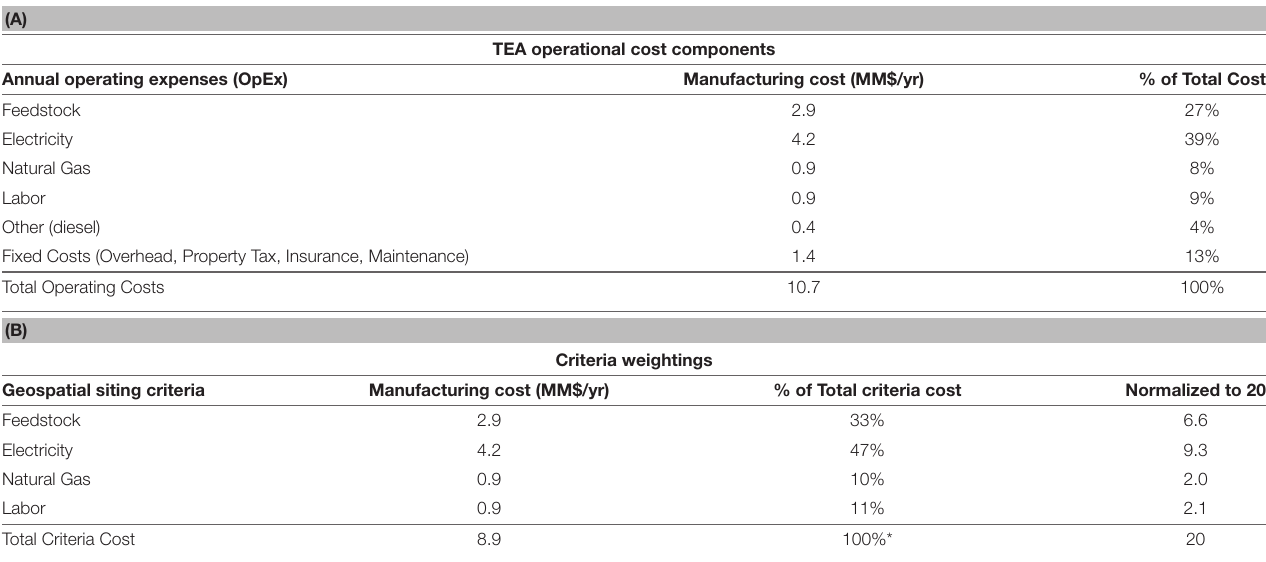
TABLE 2 | (A) Satellite depot operational costs and (B) conversion into decision matrix weights. (A)